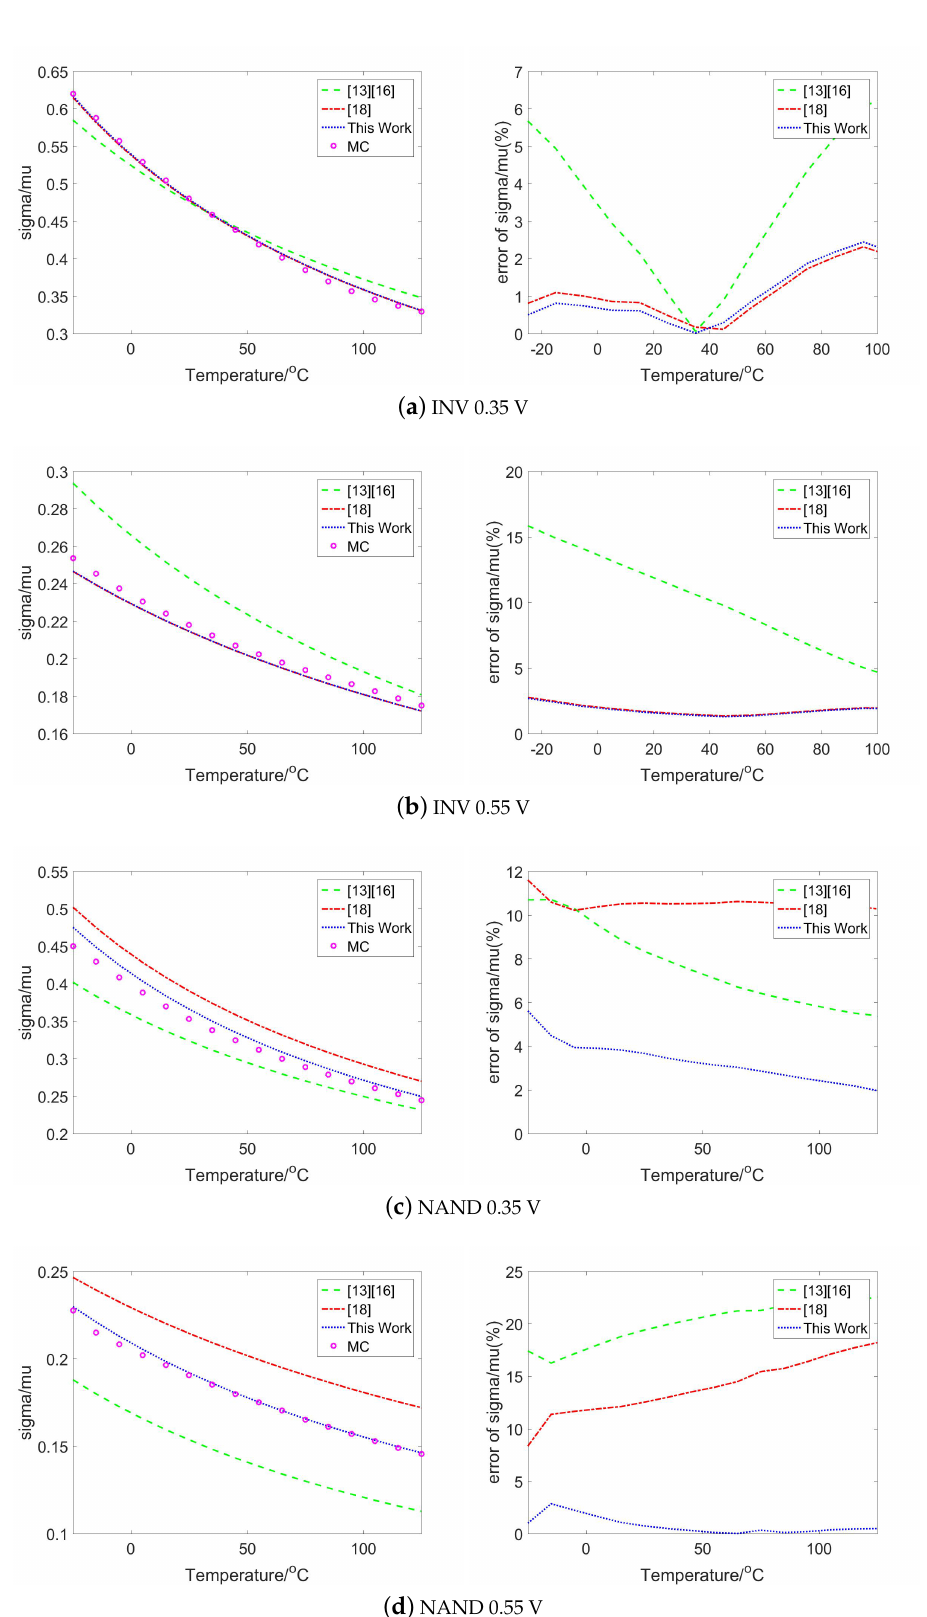
Figure 4. Comparison of delay variability with different temperature under different gates and voltages: ( a ) INV 0.35 V; ( b ) INV 0.55 V; ( c ) NAND 0.35 V; ( d ) NAND 0.55